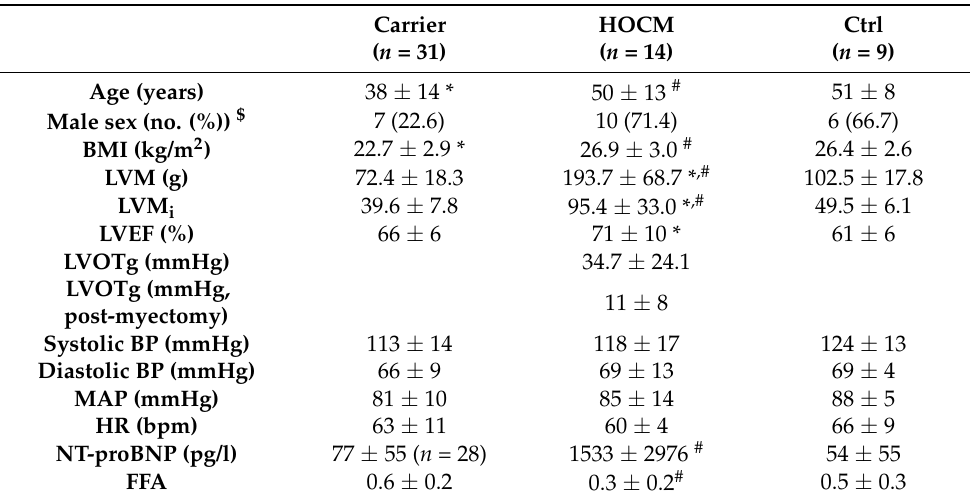
Table 1. Demographic and clinical characteristics of the study population 1